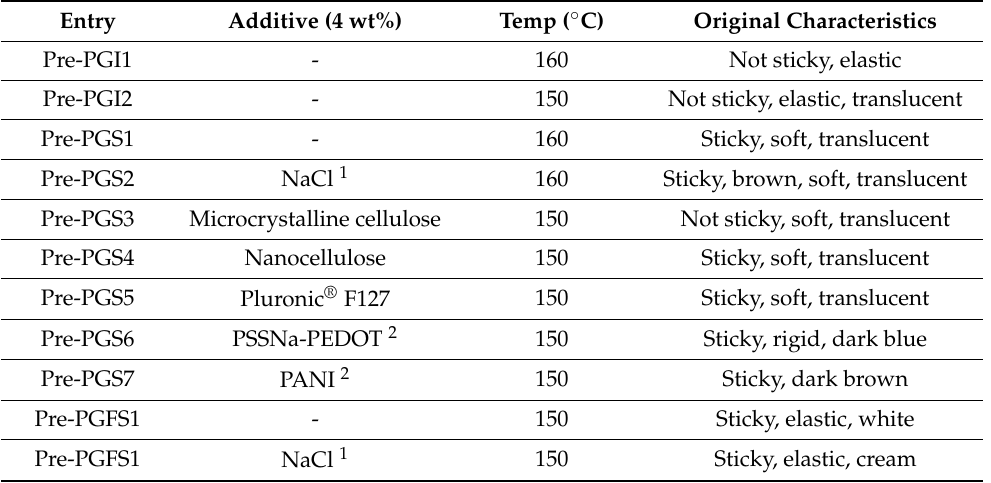
Table 1. List of prepolymers, describing their appearances and modes of